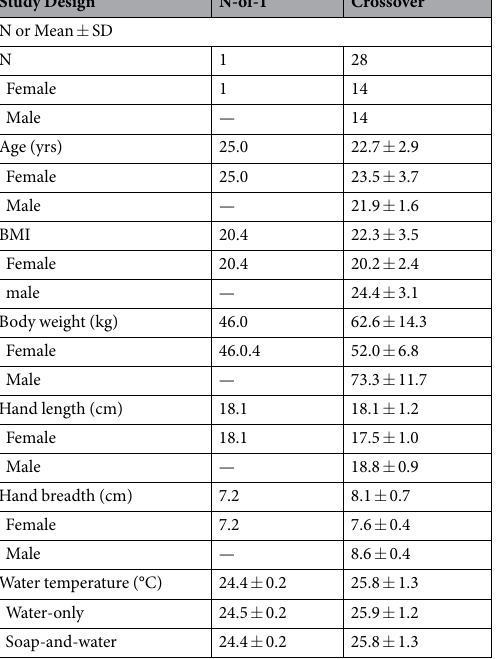
Table 1. Summary of the subject and environmental characteristics in two interventional